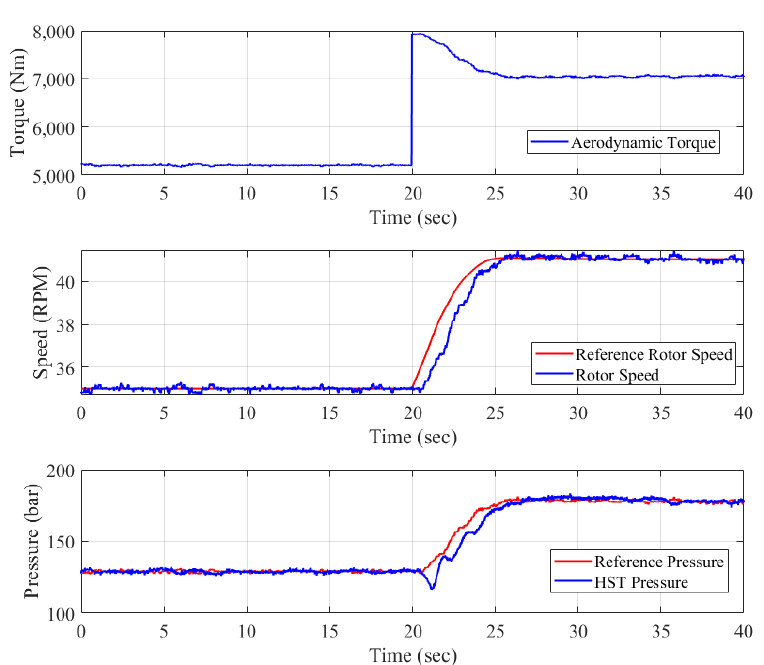
Figure 7. Performance of the HST wind turbine to a step wind Gust Wind: The aerodynamic torque applied to the rotor during a wind gust is shown in the first plot of Figure 8. It can be seen that the torque and rotor speed follow the same trend as the wind profile. The corresponding reference rotor speed and the rotor speed of the dynamometer are illustrated in the second plot. Due to the large inertia, the reference speed has a delay from the torque input. The measured HST pressure along with their reference signals are shown in the third plot. Both of the measured signals effectively track their reference counterparts, with a delay.